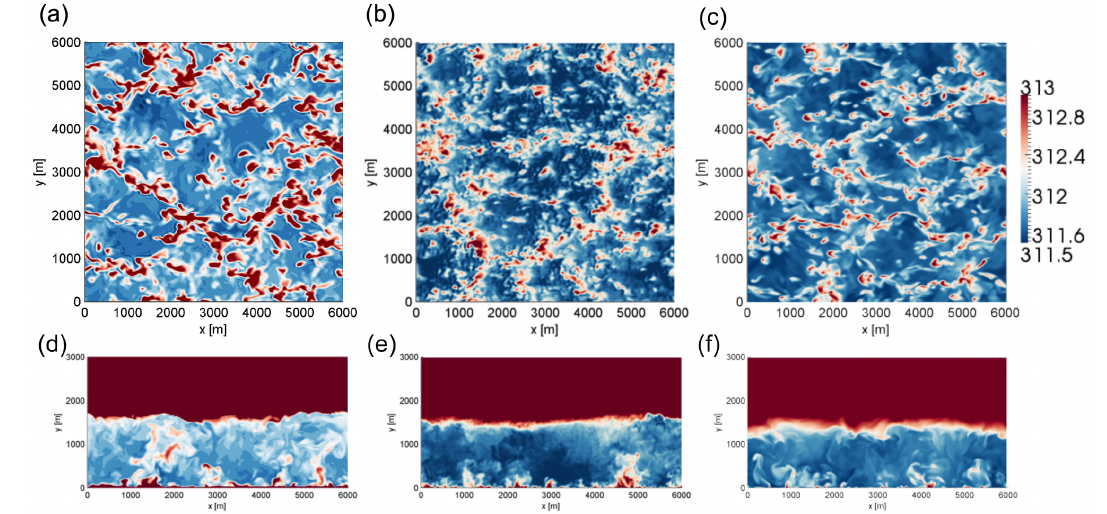
Figure 3. Comparisons of instantaneous potential temperature [K] from the unstable case study, at 100m above the surface (a, b, c) and in a cross-stream plane midway through the domain (d, e, f) from WRF (a, d) , SOWFA (b, e) , and HiGrad (c, f) . Each simulation used the same external forcing but different solver options, as described in the